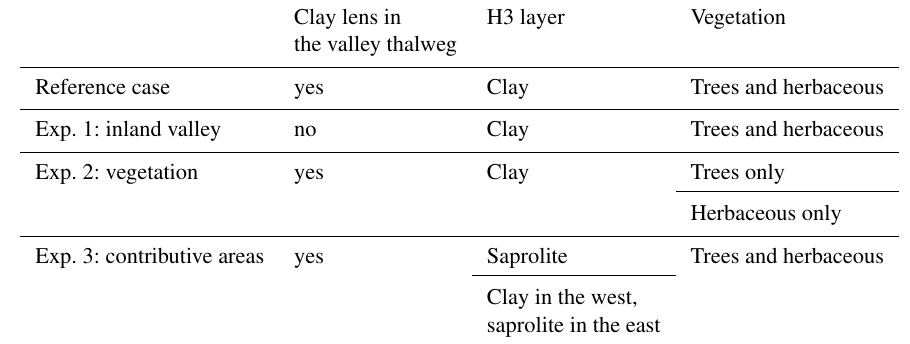
Table 4. Virtual experiments. “Trees and herbaceous” refers to trees only in riparian areas and inland valley fringes, as shown in Fig. 1. Clay lens in